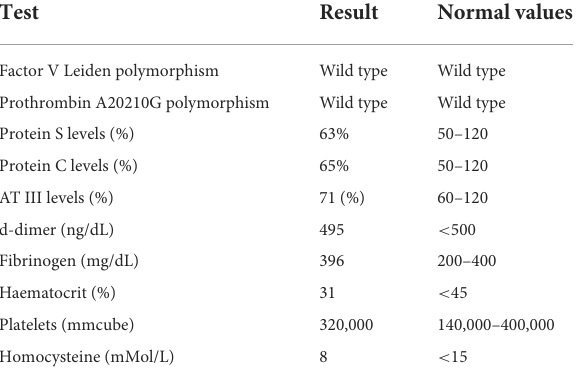
TABLE 1 Laboratory findings of reported patient.